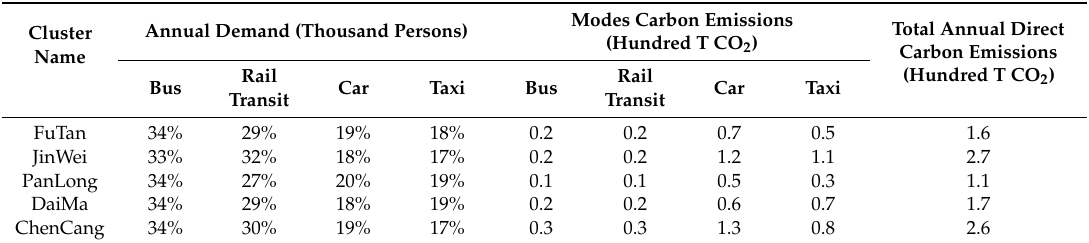
Table 6. Annual carbon emissions for the urban rail scenario in Baoji, 2023 based on tra ffi c cluster